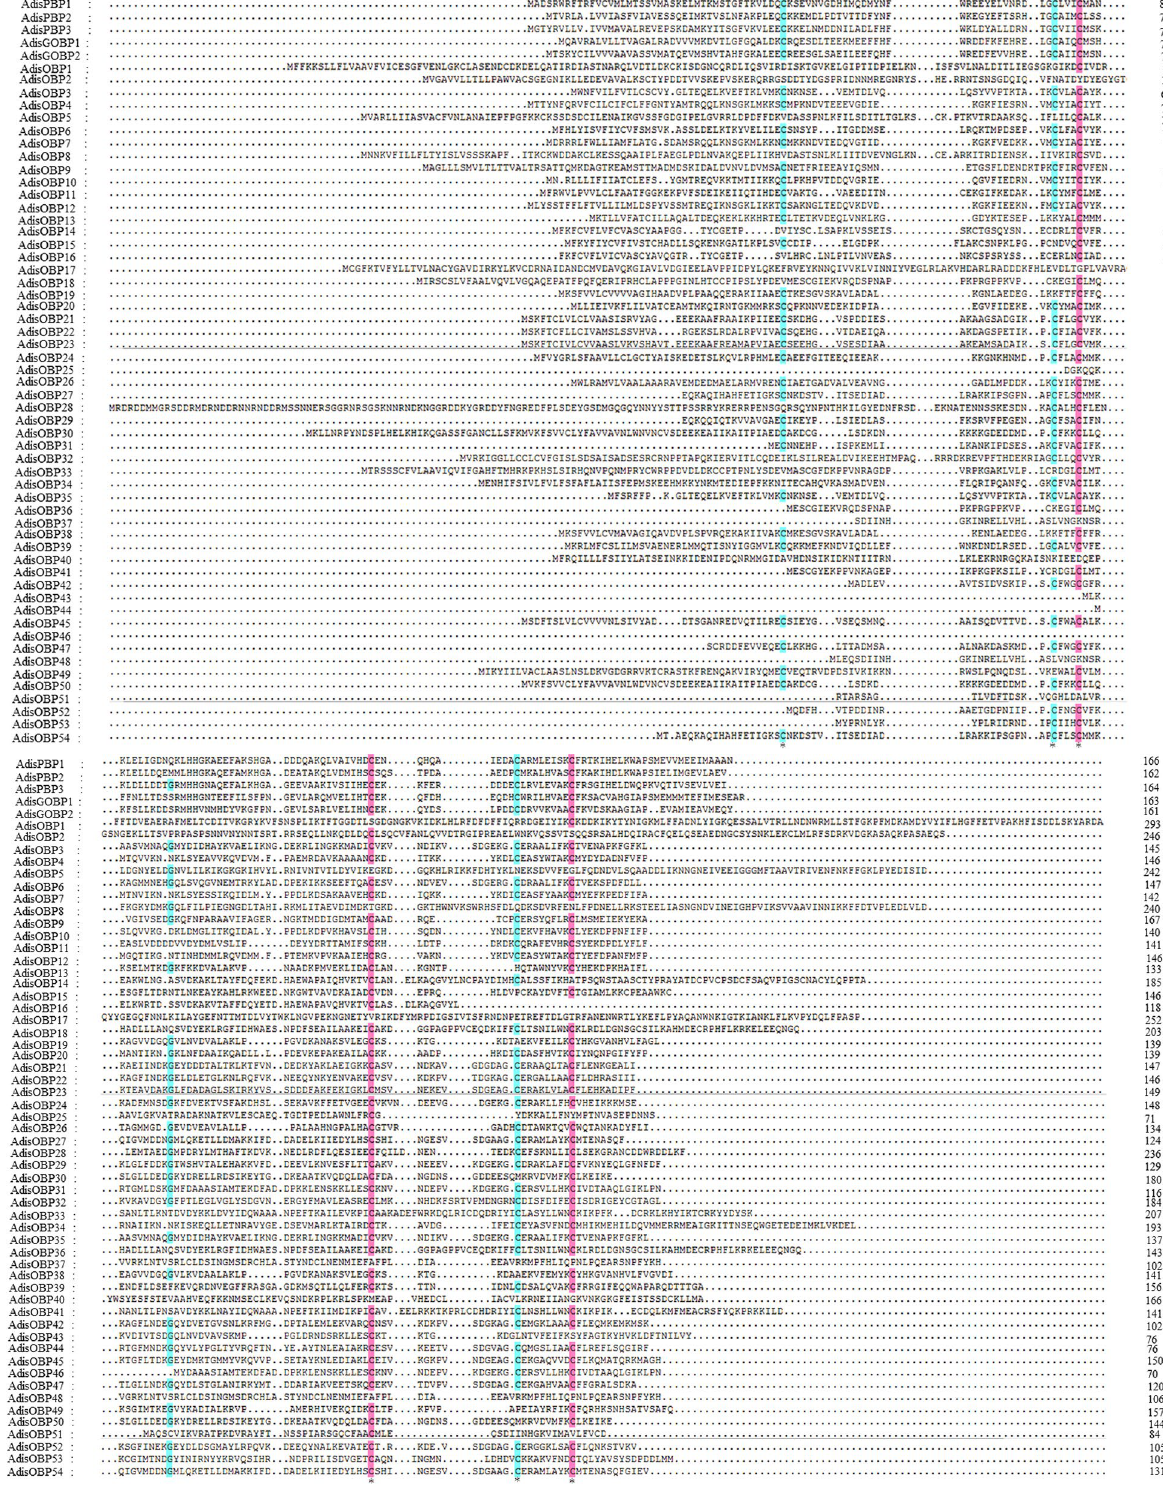
Figure 3. Sequence alignments of Athetis dissimilis OBPs. The six conserved cysteine residues are indicated with the asterisks under the